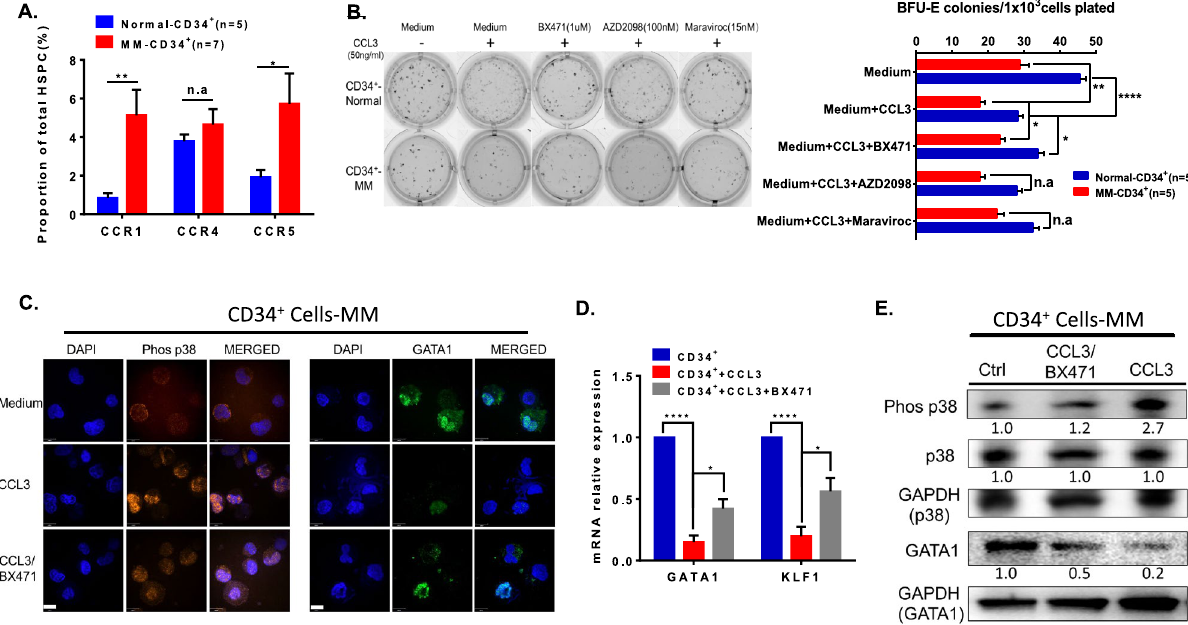
Figure 7. A high level of CCL3 suppresses erythroid differentiation of HSPCs via activation of the CCL3/ CCR1/p38 signalling pathway in MM. ( A ) Flow cytometry analysis showing the expression of CCL3 receptors (CCR1, CCR4 and CCR5) in CD34 + cells from normal donors and NDMM patients. ( B ) The CFC assay showed the BFU-E colony-forming ability of CD34 + cells in the presence or absence of CCL3 (50 ng/ml) and the CCR1 antagonist BX471 (1 μM), the CCR4 antagonist AZD2098 (100 nM), or the CCR5 antagonist maraviroc (15 nM) (left graphs). The histograms indicate the absolute number of BFU-E colonies formed (right). ( C ) Immunofluorescence staining of phosphorylated p38 (orange) and GATA1 (green) in EPO- induced HSPC (CD34 + ) differentiation in the presence or absence of CCL3/BX471. Nuclei were stained with DAPI. Fluorescence images viewed under a confocal microscope were acquired. The scale bar indicates 10 μm. ( D ) RT-PCR analysis showed the expression levels of GATA1 and KLF1 in CD34 + cells in the presence or absence of CCL3/BX471. GAPDH expression was used as an internal control. ( E ) Western blotting analysis of phosphorylated p38 (phos-p38), total p38 and GATA1 after the induction of erythroid differentiation in the presence or absence of CCL3/BX471. GAPDH expression was used as an internal